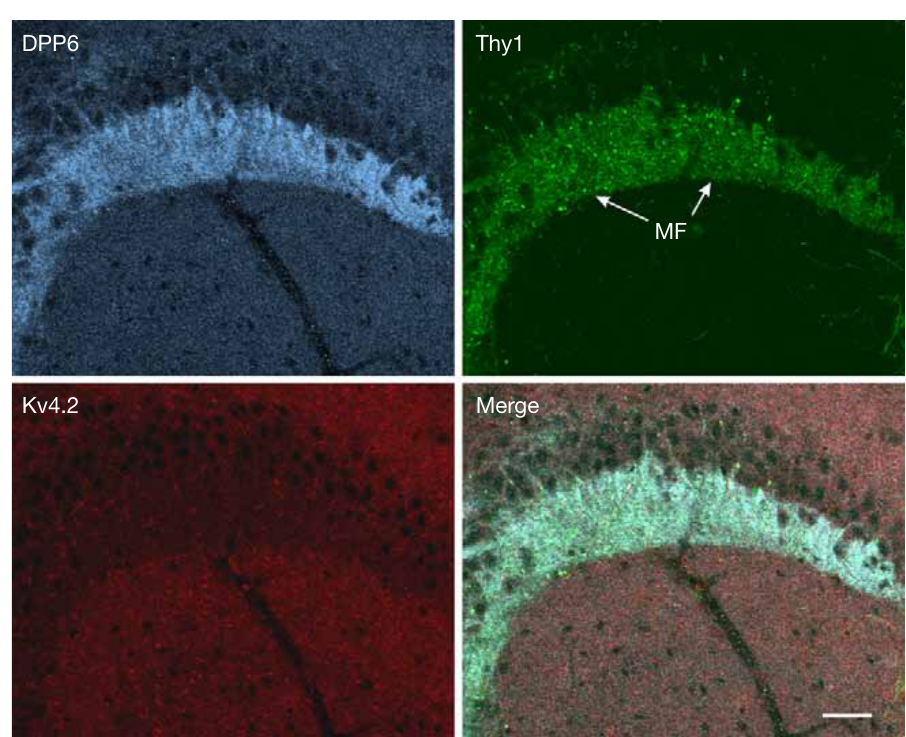
Figure 9 | DPP6, but not Kv4.2, is expressed in the hippocampal mossy fi bers. Confocal images of the hippocampus of a Thy1-H mouse expressing YFP (green) in the mossy fi bers (MF) double labeled for Kv4.2 (red) and DPP6 (light blue). The three images are shown superimposed in the lower right panel (merge). Note the strong immunolabeling of the mossy fi bers in the stratum lucidum with DPP6 antibodies and lack of staining with antibodies to Kv4.2. Scale bar: 50 μ